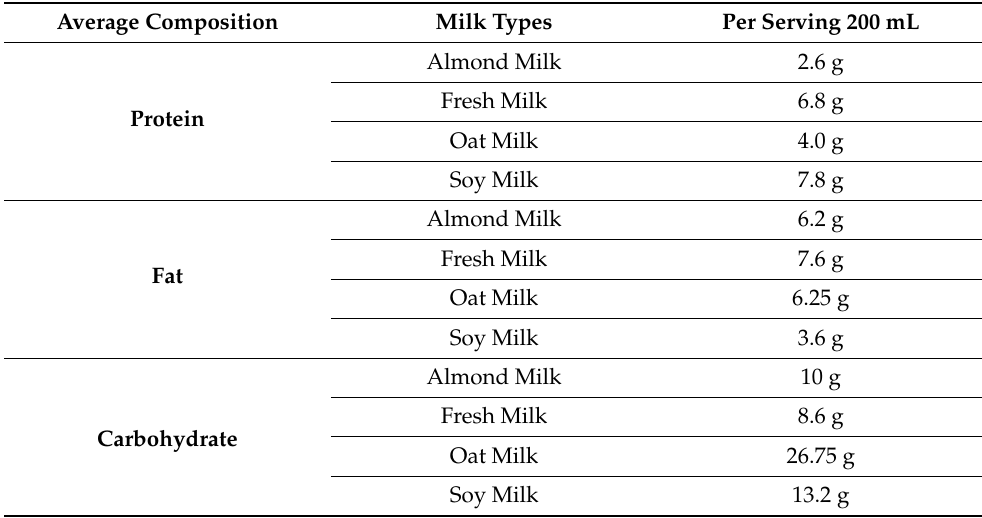
Table 1. Main compositions of each milk per 200